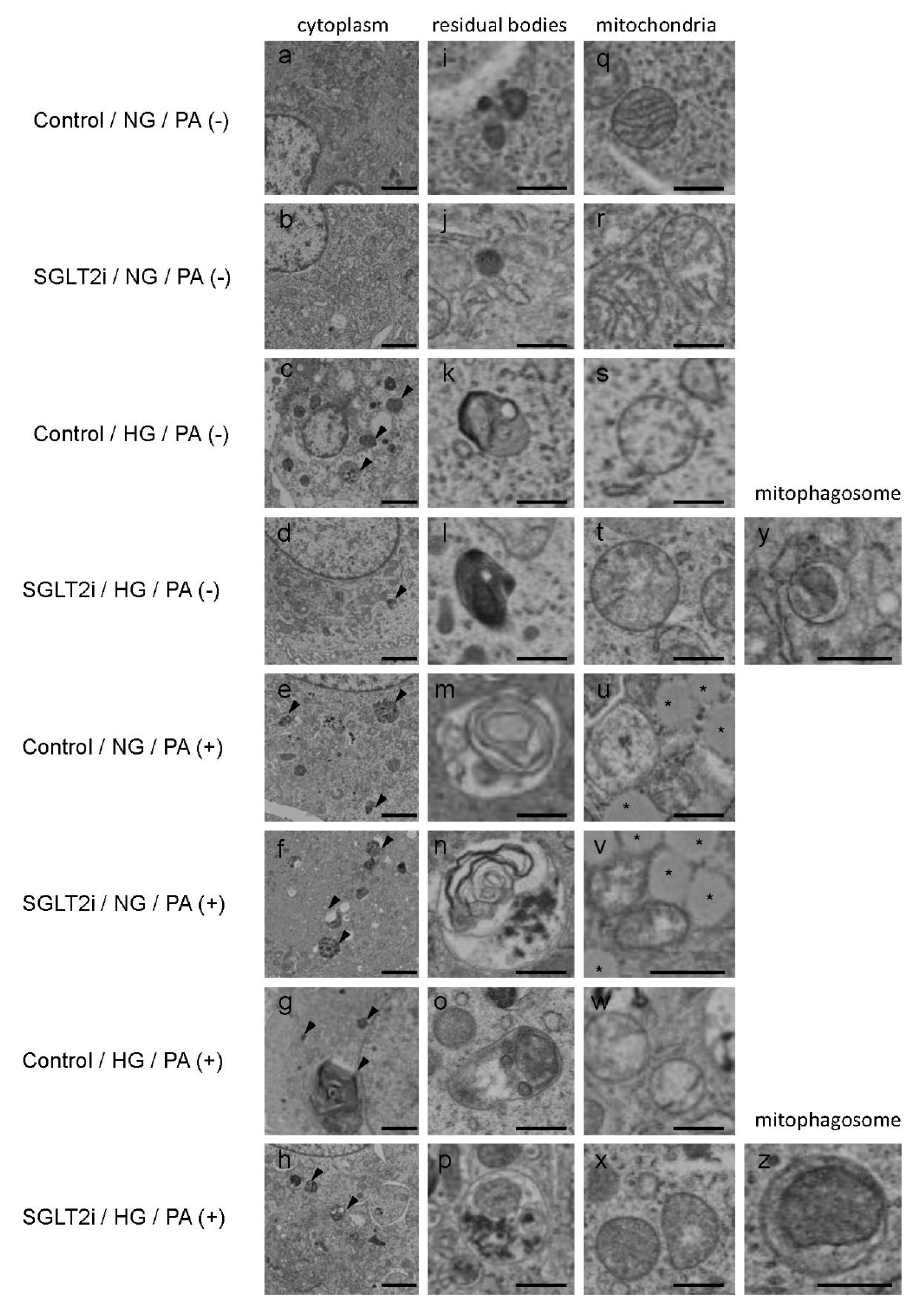
Figure 6. SGLT2 inhibitor (SGLT2i) increased autophagosomes of damaged mitochondria in LLC-PK1 cells. ( a – h ) Cytoplasm of LLC-PK1 cell; arrowhead: residual bodies; bars: 2.0 µ m. ( i – p ) Representative images of residual bodies; bars: 500 nm. ( q – x ) Representative images of mitochondria; asterisk: lipid droplets; bars: 500 nm. ( y , z ) Representative images of mitophagosomes; bars: 500 nm. SGLT2i: empagliflozin. Taken together, SGLT2i ameliorates lysosomal dysfunction of obesity mice by mainly protecting PTCs from high glucose exposure, resulting in autophagy flux improvement.